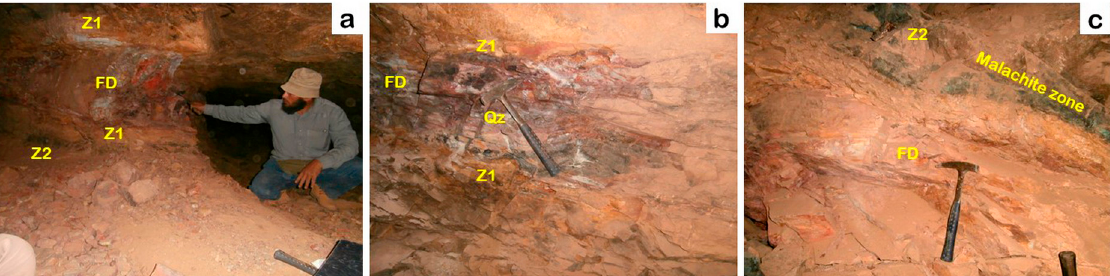
Figure 6. ( a ) Felsite dike cut through granodiorite rocks with different alteration zones stained with iron oxides. ( b ) Discontinuous quartz enclaves are encountered along the felsite dikes stained with iron oxides. ( c ) Malachite rich band in zone-2. Abbreviations: felsite dike (FD); alteration zone-1 (Z1); alteration zone-2 (Z2); and quartz veinlets (Qz).